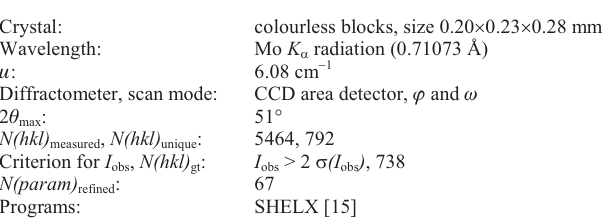
Table 1. Data collection and handling.